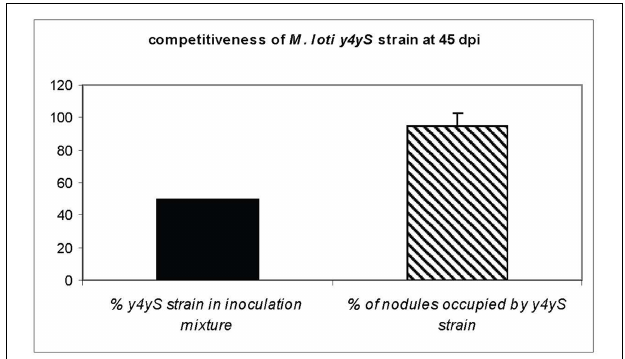
FIGURE 2 | Competition assay on Lotus tenuis cv. Esmeralda. Plants were co-inoculated with an equal mixture of the wild-type and y4yS mutant strains. The percentage of nodules occupied by the y4yS strain at 45 days post-inoculation (dpi) is